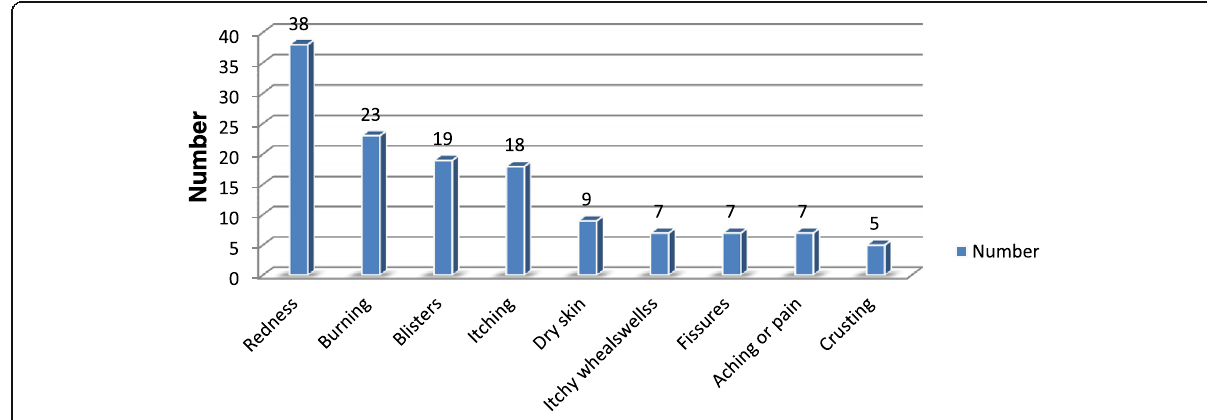
Fig. 3 Perceived symptoms of contact dermatitis among healthcare workers in Gondar town, Ethiopia, 2018 ( n =